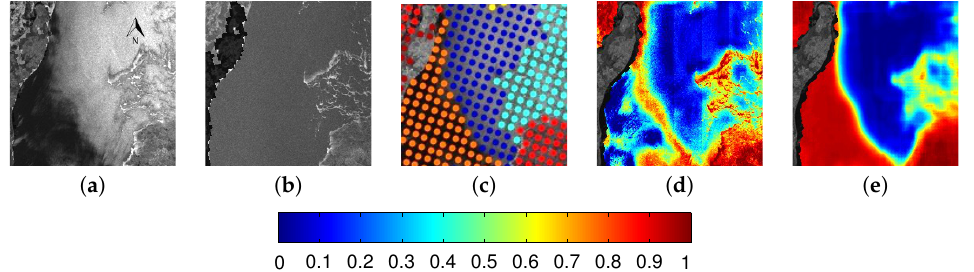
Figure 6. An example shows the details for a region with new ice and water. The ASI result is mainly water for this region. It can be seen MLP40 ( d ) produces noisy ice concentration estimates with new ice in the bottom left identified as water with some ice of low ice concentration. The CNN ( e ) is able to correctly identify new ice and water with higher accuracy. Subscene of dimension 60 km × 60 km from 20140117_103914 centered at 47.60 ◦ N, 64.13 ◦ W. The HH image, HV image and image analysis are shown in panels ( a – c ) respectively.